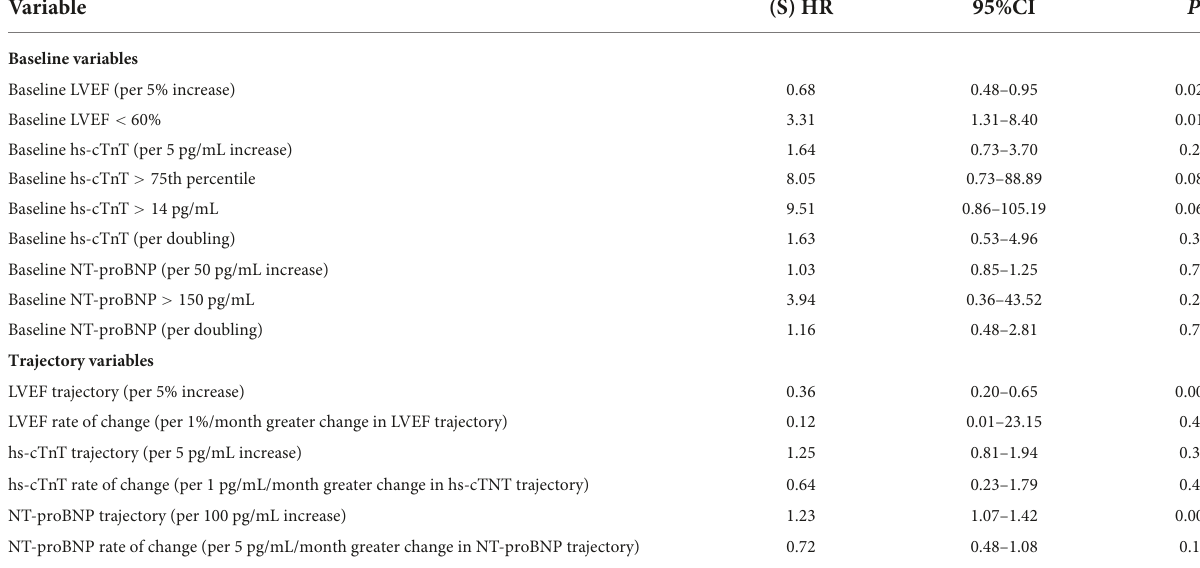
TABLE 2 Associations between baseline and longitudinal left ventricular ejection fractions, high-sensitivity troponin T, N-terminal pro-brain natriuretic peptide, and cardiotoxicity.